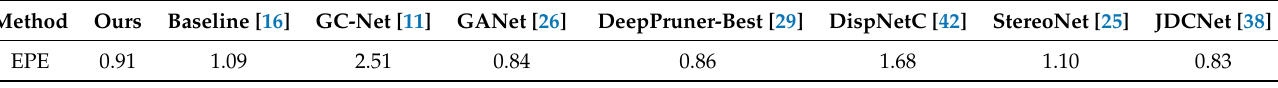
Table 4. Evaluation results on the Scene Flow dataset. Our model is competitive with other top-performing models.